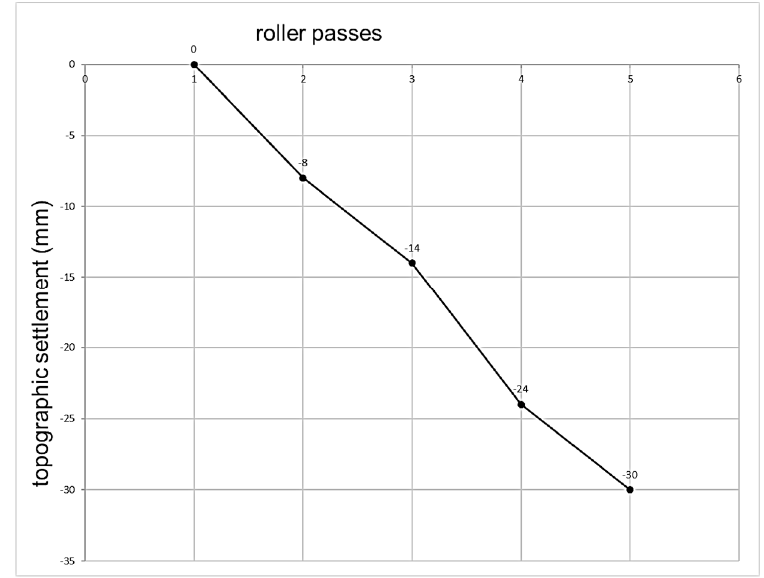
Figure 2. Topographic settlement. Experimental section granite rockfill 1000 mm.